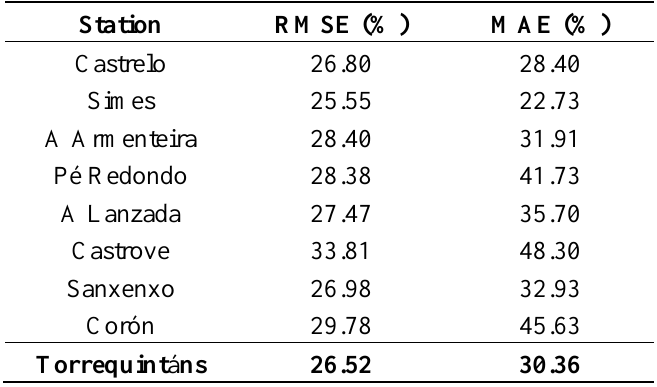
Table 7. RMSE and MAE obtained with the MLR